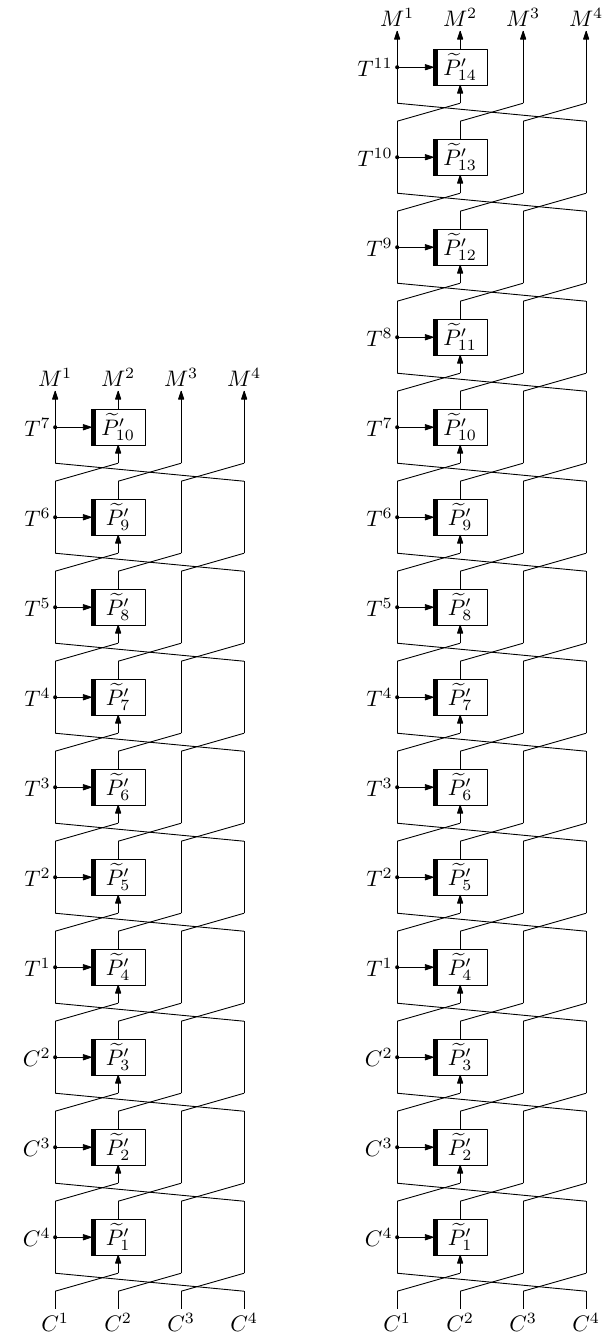
with d = 4, where the TRPs and the internal states are Figure 10: Examples of E − 1 1 ,d,r labeled as in the proof of Lemma 7. Left: E − 1 ( C 1 ∥ · · · ∥ C 4 ) = ( M 1 ∥ · · · ∥ M 4 ) for 1 ,d,r ( C 1 ∥ · · · ∥ C 4 ) = ( M 1 ∥ · · · ∥ M 4 ) for r = d 2 − d + 2 = r = d 2 − 2 d + 2 = 10. Right: E − 1 1 ,d,r